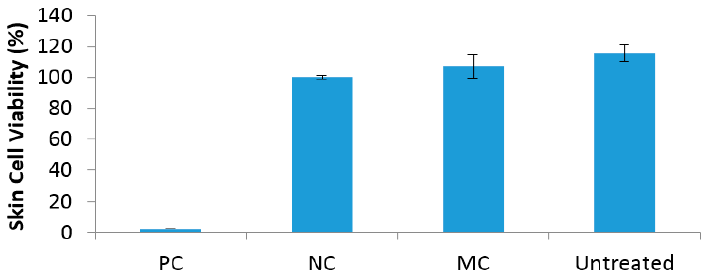
Figure 4. Skin irritation of PC (positive control), NC (negative control), MC-treated wound dressing specimen and untreated wound dressing specimen tested in an in vitro reconstructed human epidermis prediction model EpiDerm™.